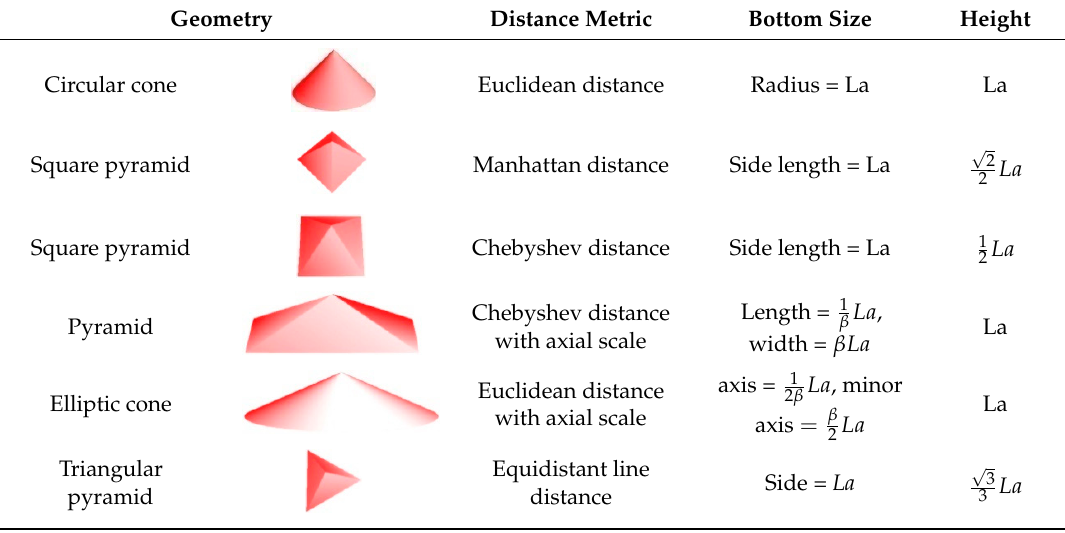
Table 1. Shapes and sizes of geometries corresponding to different distance metrics.